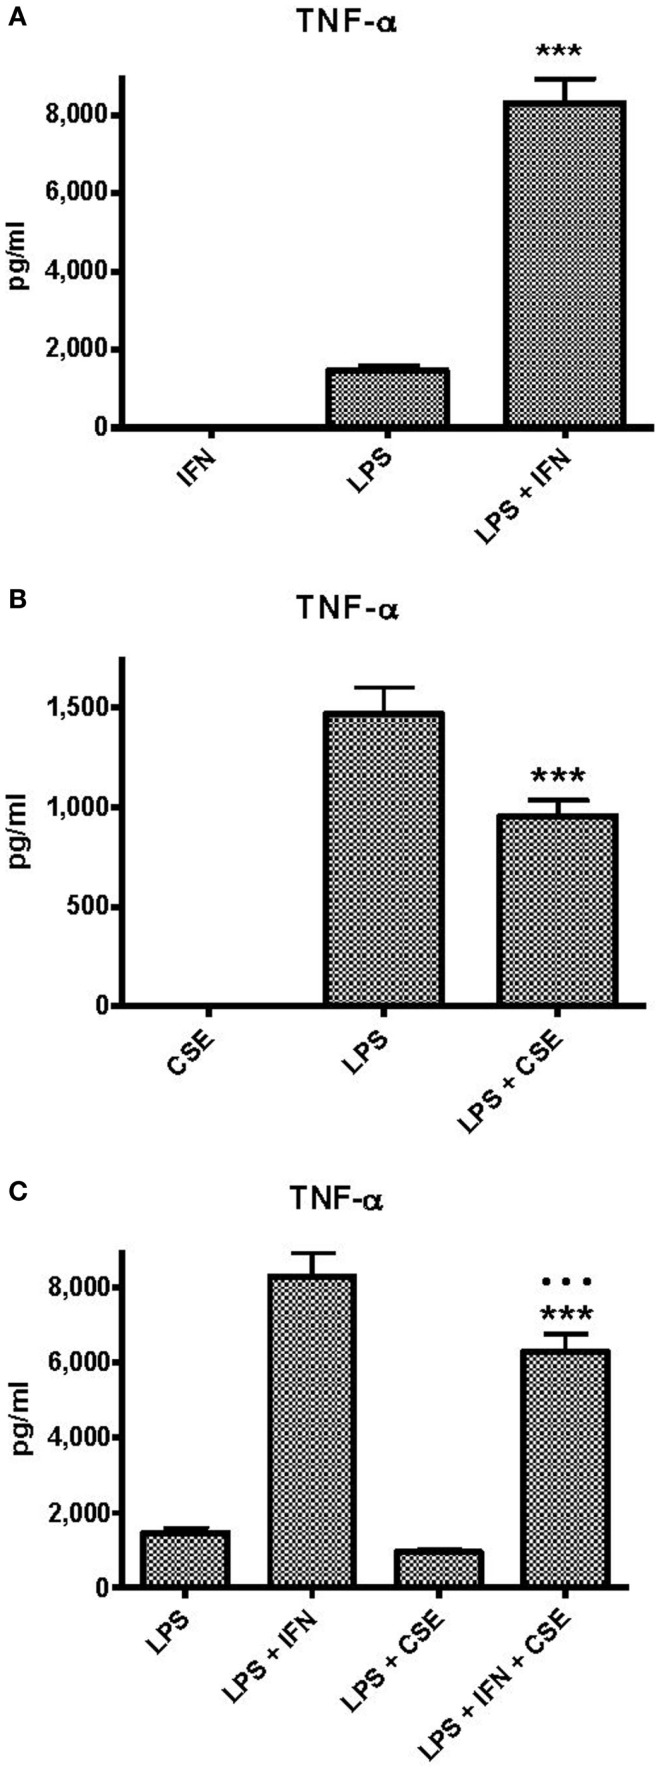
Effects of IFN-γ and CSE on TNF-α responses of PBMC to LPS (50 ng ml−1). (A) Effect of IFN-γ (10 ng ml−1) pre-treatment on LPS stimulation of TNF-α from PBMC (n = 28) (*** =p < 0.0001). (B) The effect of CSE (0.001 cig ml−1) pre-treatment on LPS (50 ng ml−1) stimulation of TNF-α from PBMC (n = 28) (*** =p < 0.0001). (C) The effect of CSE (0.001 cig ml−1) and IFN-γ (10 ng ml−1) pre-treatment on LPS stimulation of TNF-α from PBMC (n = 28) (*** =p < 0.0001).